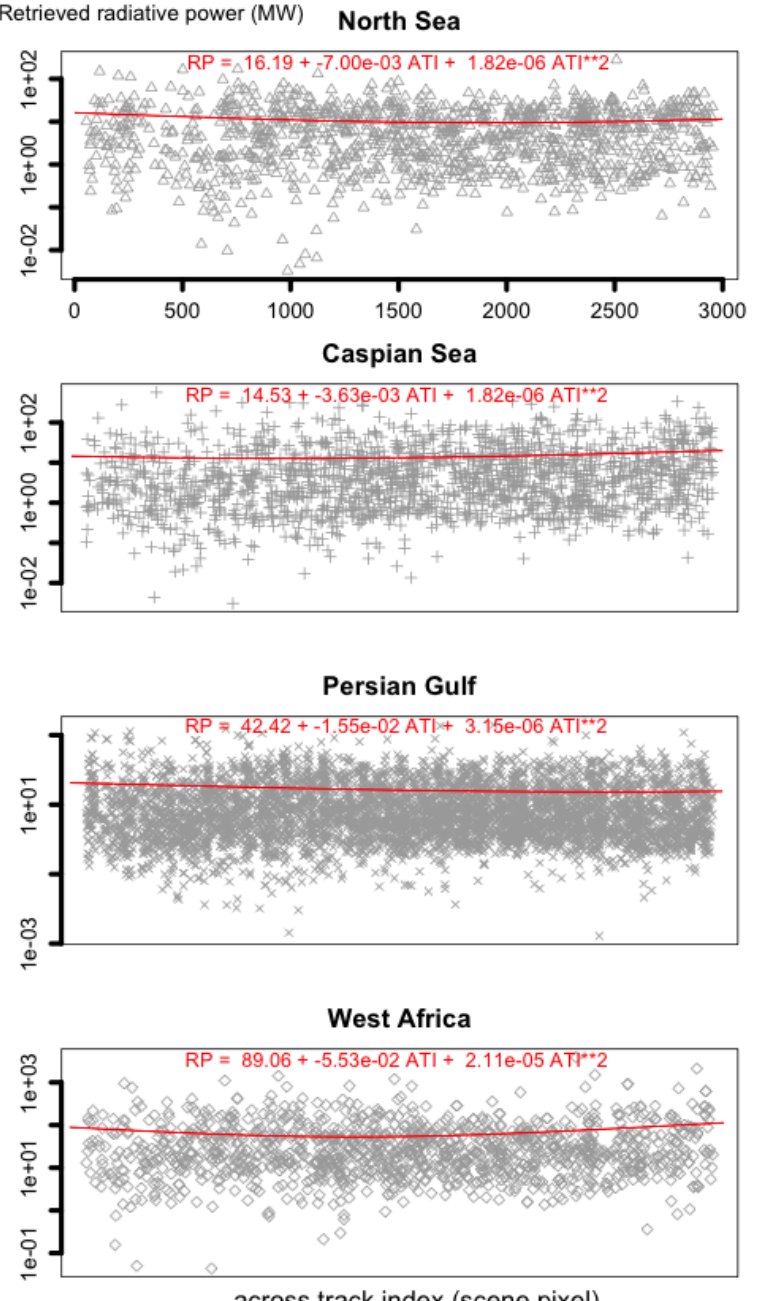
Figure 11. Retrieved radiative power for hot spots as a function of the across track index